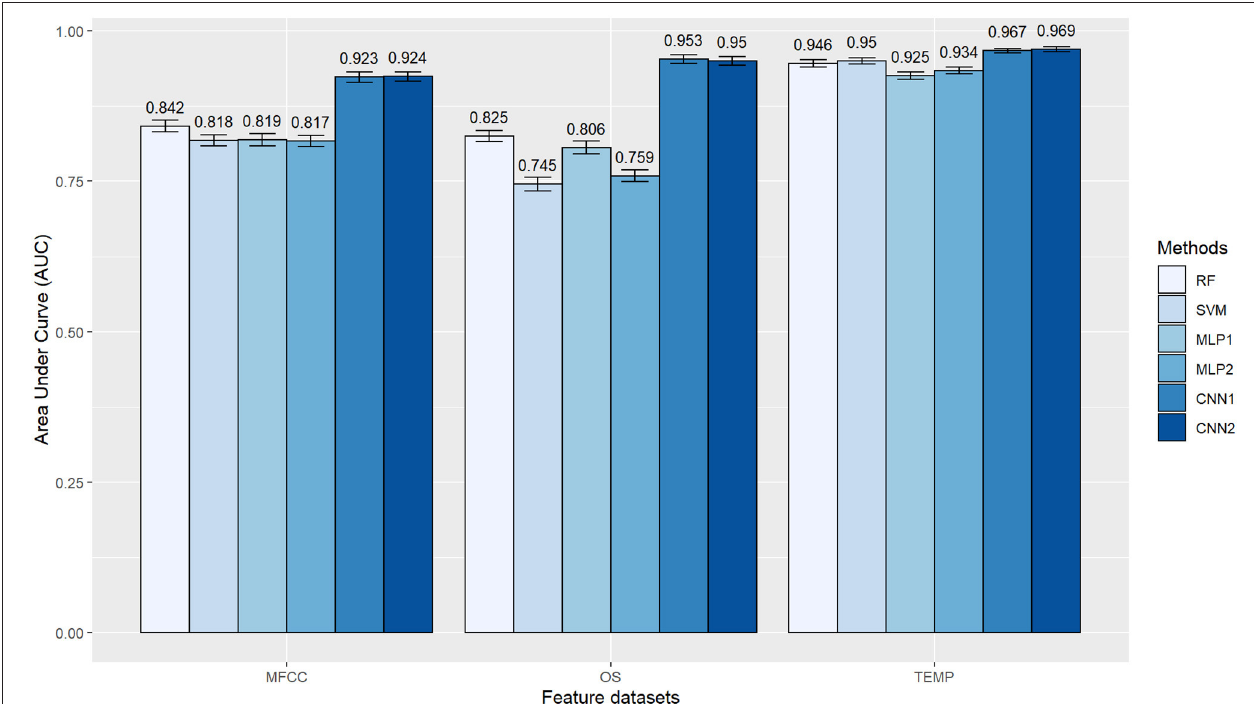
FIGURE 9 | Area under the curve (AUC) obtained with different algorithms (RF, Random Forest; SVM, Support Vector Machine; MLP, Multilayer Perceptron Neural Networks; CNN, Convolutional Neural Networks) for the classification of gait types ( marcha batida and marcha picada ) in Brazilian horses according to the audio-feature dataset used as input information (MFCC, Mel-frequency Cepstral Coefficients; OS, Onset Strength; TEMP, Tempogram). AUC values were obtained in a five-fold cross-validation scheme with 10 random repetitions. MLP1, MLP2, CNN1, and CNN2 refer to the different neural network architectures used for each audio-feature dataset, as fully described in Supplementary Table 1